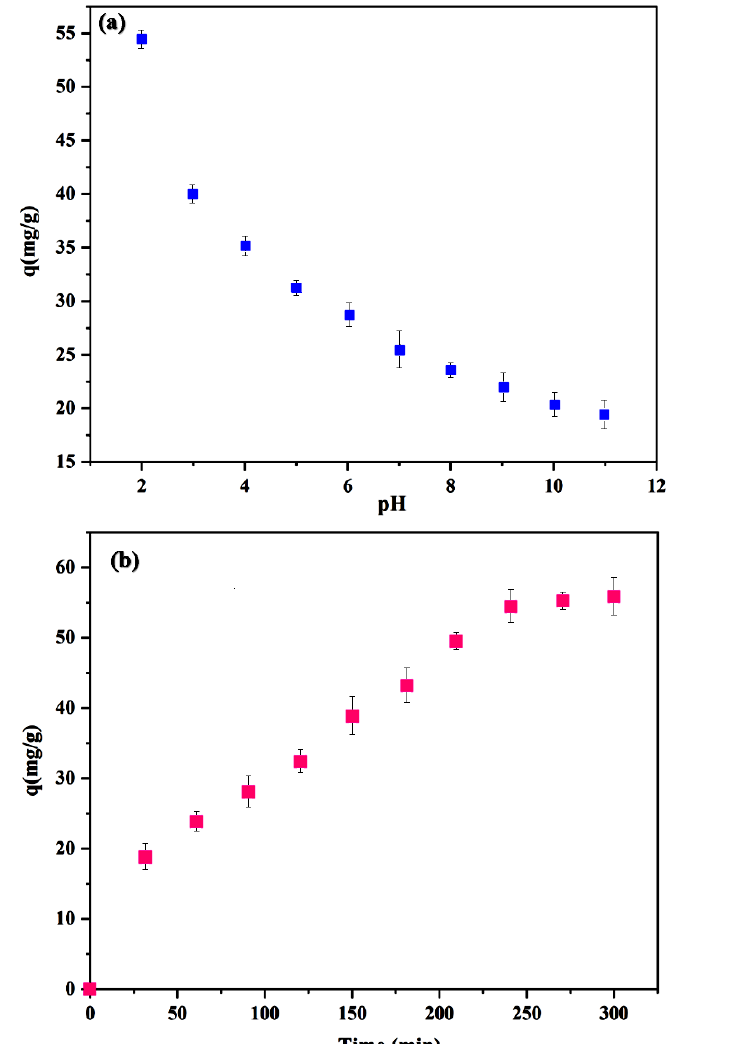
Fig. 6. a) Effect of pH value on adsorption of Rh B (0.1 g hydrogel, 40 ppm Rh B, 4 h, R. T) and b) Effect of contact time on